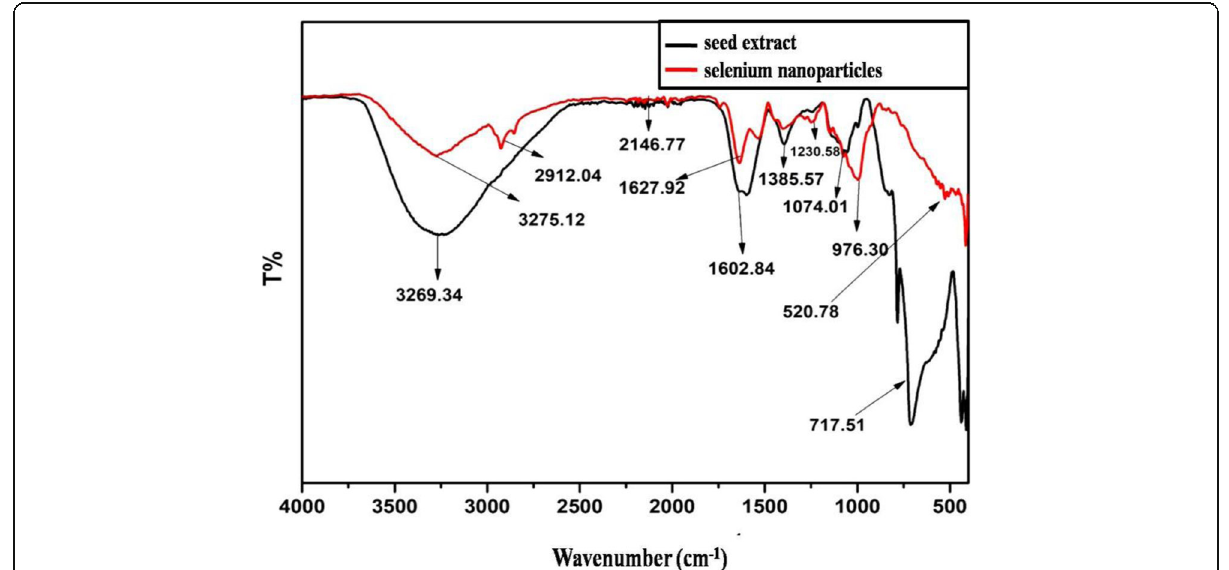
Fig. 5 FTIR analysis of the biosynthesised selenium